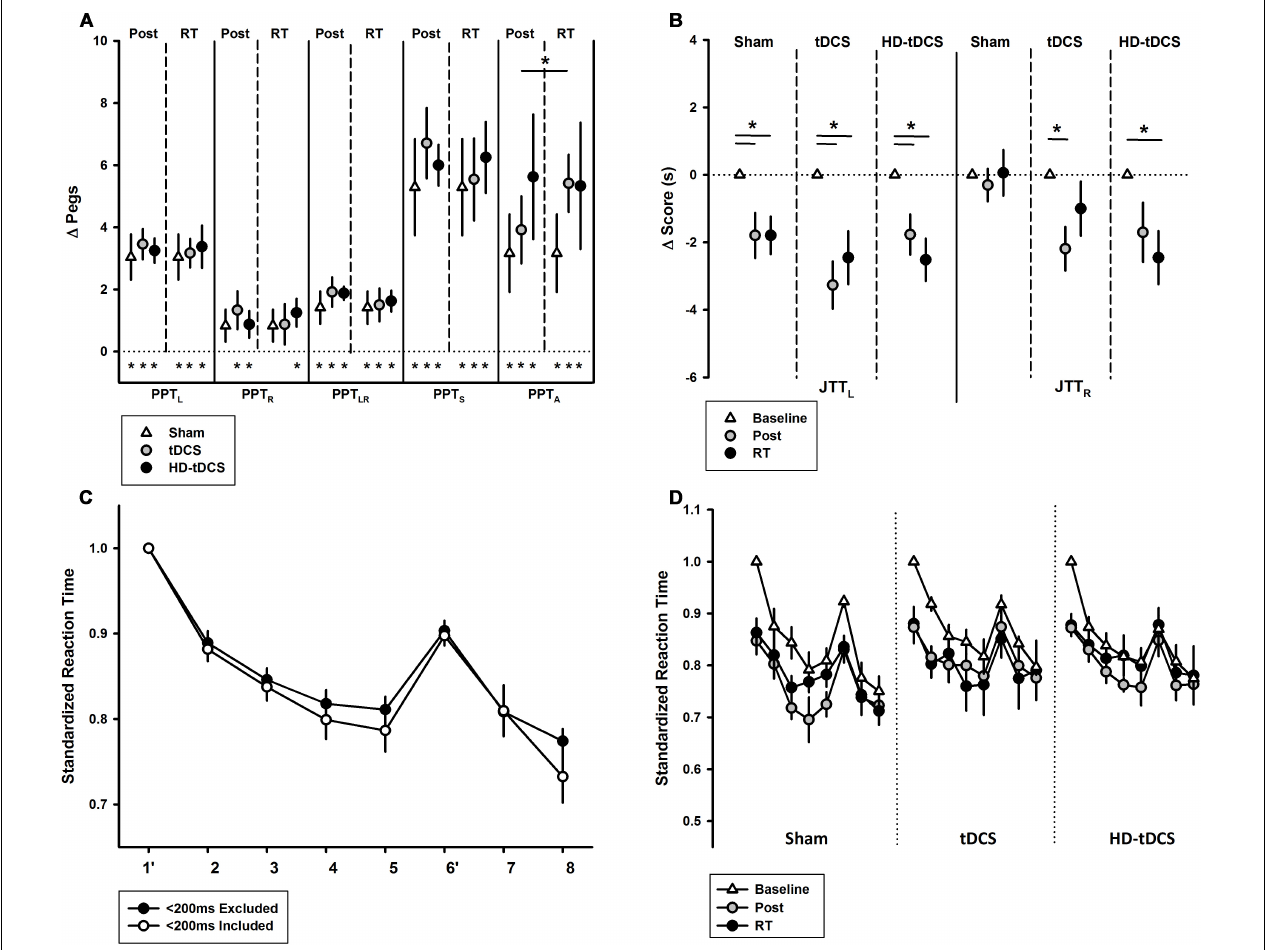
FIGURE 5 | Secondary motor outcomes. (A) Change in Purdue Pegboard Test (PPT) scores at post-training and retention time (RT) demonstrated treatment group effects for PPT A . PPT subtests are left (PPT L ), right (PPT R ), bimanual (PPT LR ), sum of scores (PPT S ), and assembly (PPT A ). ∗ p < 0.05. (B) Jebsen–Taylor Test of Hand Function left and right (JTT L , JTT R ) demonstrated treatment group effects bilaterally at post-training and RT. (C) Serial Reaction Time Task (SRTT) curves